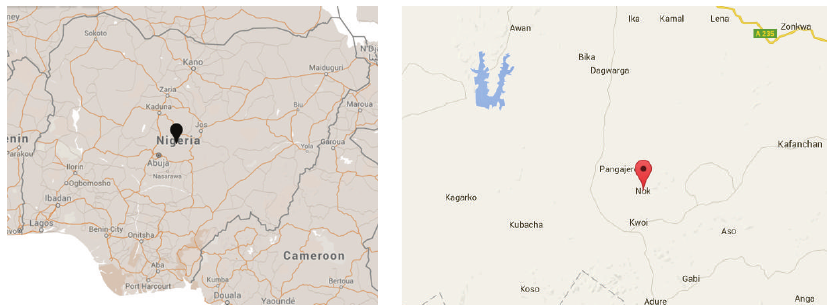
Figure 1: Maps showing Nok village in Kaduna State, Nigeria (taken from Google